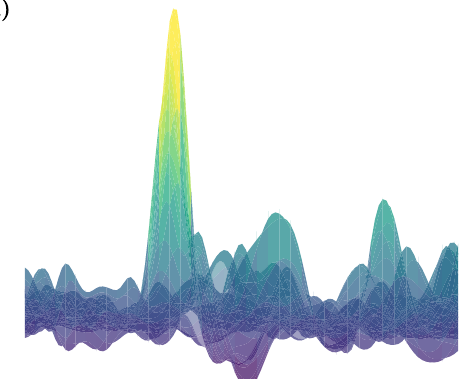
Fig. 1 | Typical shape of loss landscape. Loss landscapes of underparameterized quantum variational algorithms generally appear “ bumpy, ” fi lled with various local minima and traps. Here, we plot the loss landscape as a a surface and b contour plot along two random normalized directions for the teacher-student